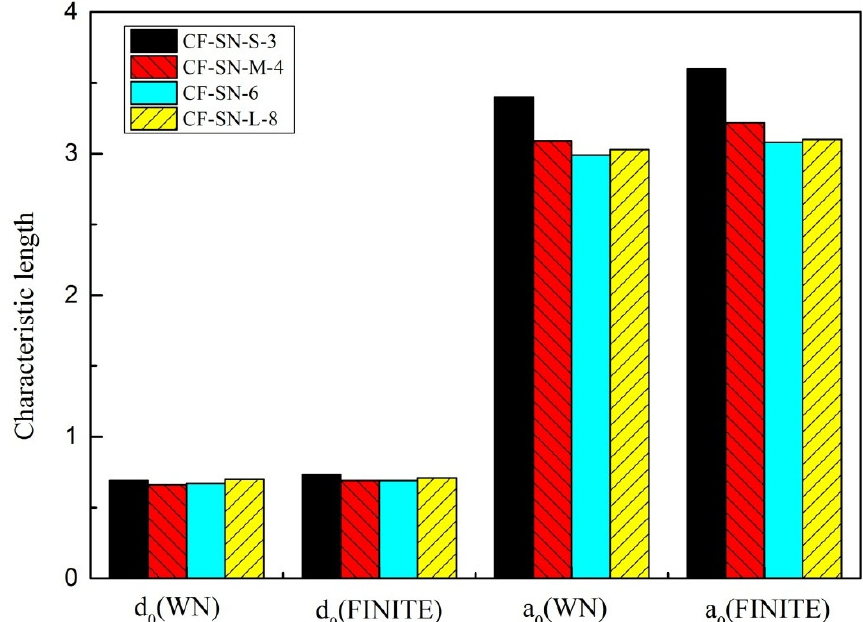
Figure 19. Characteristic lengths of the equal ratio ( W /2 C ) group calculated by the WN stress criteria and finite-width stress model; the size ratio of the notch to the specimen remained at 1:6 (which can be approximately regarded as an infinite-width plate), so the characteristic length of each specimen in this group is fairly consistent.